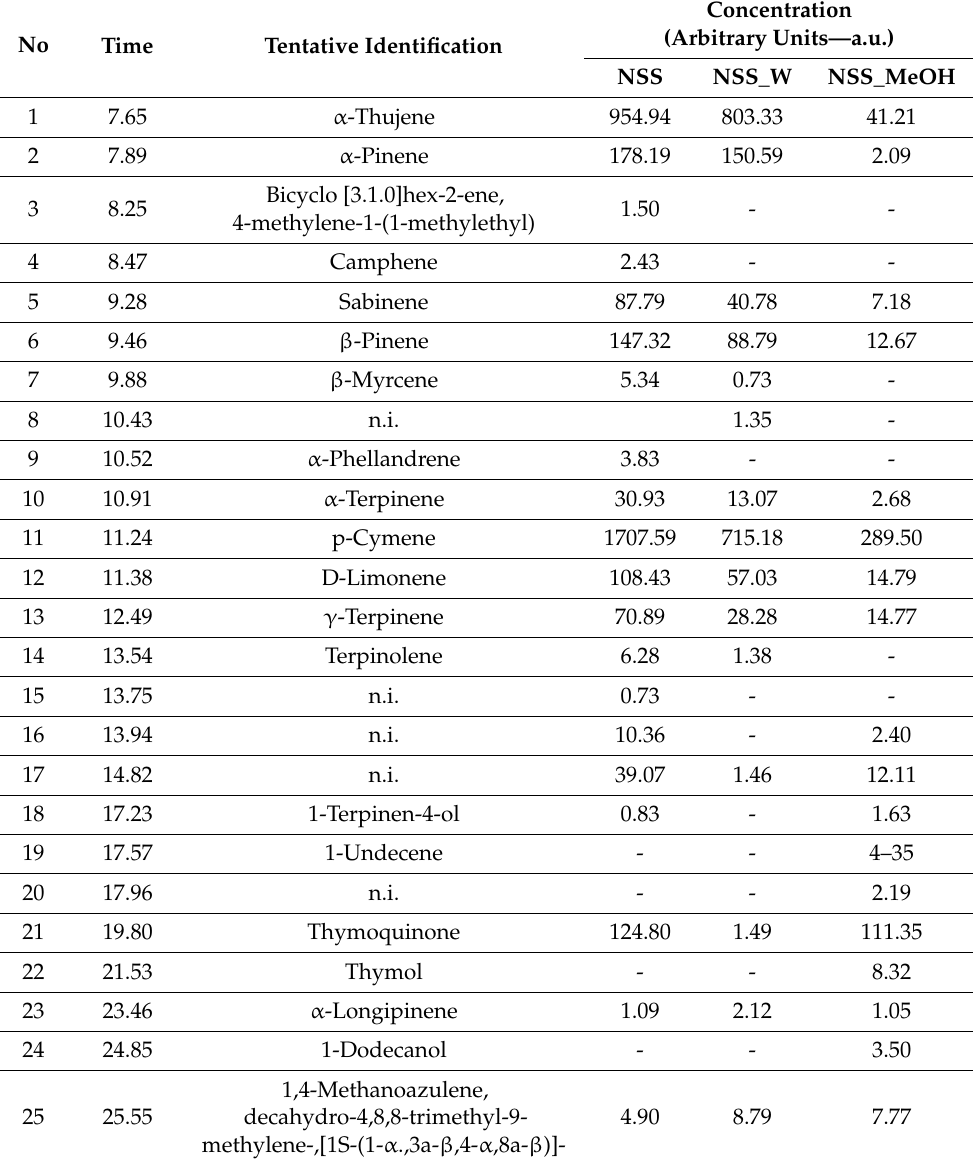
Table 4. Tentative identification of major compounds identified in Nigella sativa seeds comparative with Nigella sativa seeds water and methanolic